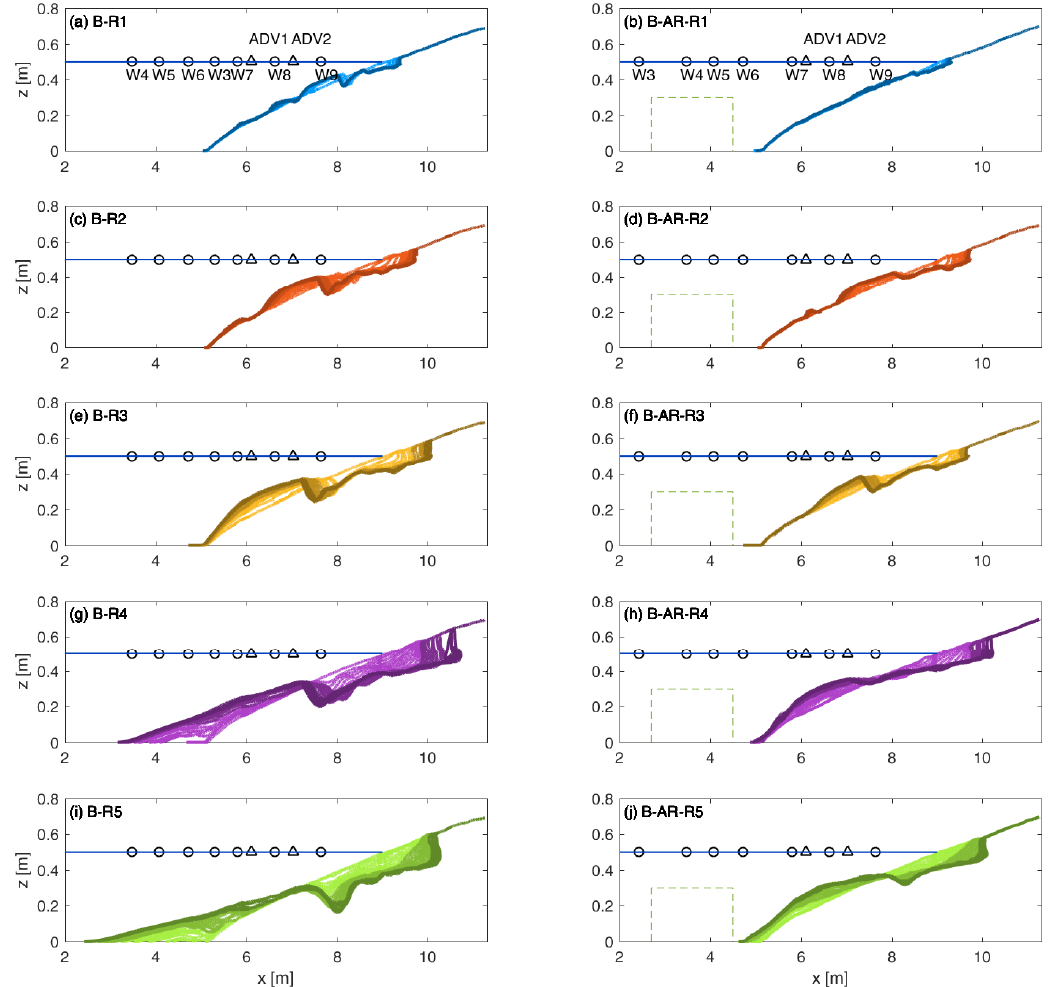
Figure 6. Bed evolution under regular wave climates (left panels show the profile type B, and right panels show the profile type B-AR, where profiles are shown with colors changing from light to dark as time progresses; the profiles are captured in di ff erent time intervals for wave climates, which are 5 min for R1, 1 min for R2 and R3, 20 s for R4, and 10 s for R5. The green dash line rectangle in the right panel depicts the AR; the horizontal blue line represents the still water level, and the black circles are wave gauges and triangles are ADVs in Figure 2) Table 3. The final volume changes of the lower and upper parts of the evolved profile relative to the initial profile under regular waves ( xm is the intersection of the initial and final slopes; V d and V e are the volume changes of the lower and upper parts, which are positive and negative, indicating deposition and erosion; Δxm , ΔV d , and ΔV e are the difference between the variables in B and B-AR tests under specific wave climate; p is the percentage of the decreased erosion volume defined as ΔV e divided by V e in B tests.). Test Name